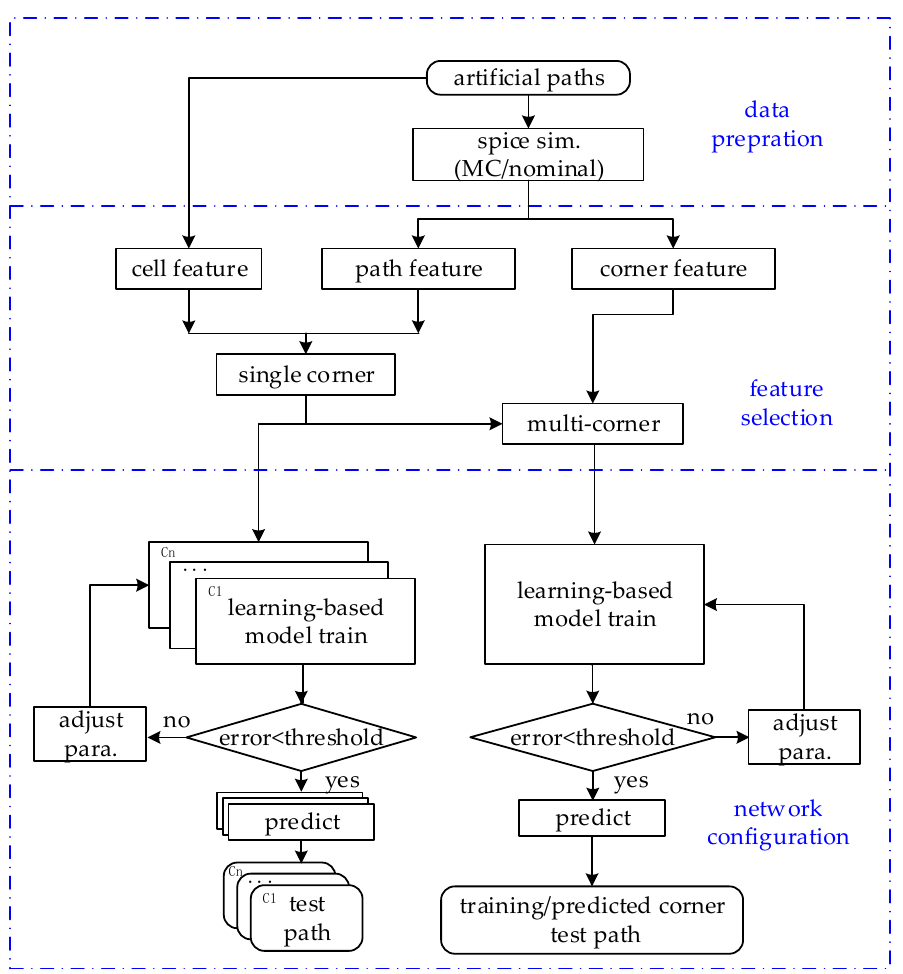
Figure 1. The flowchart of the prediction framework for path delay variation based on ML algorithm.